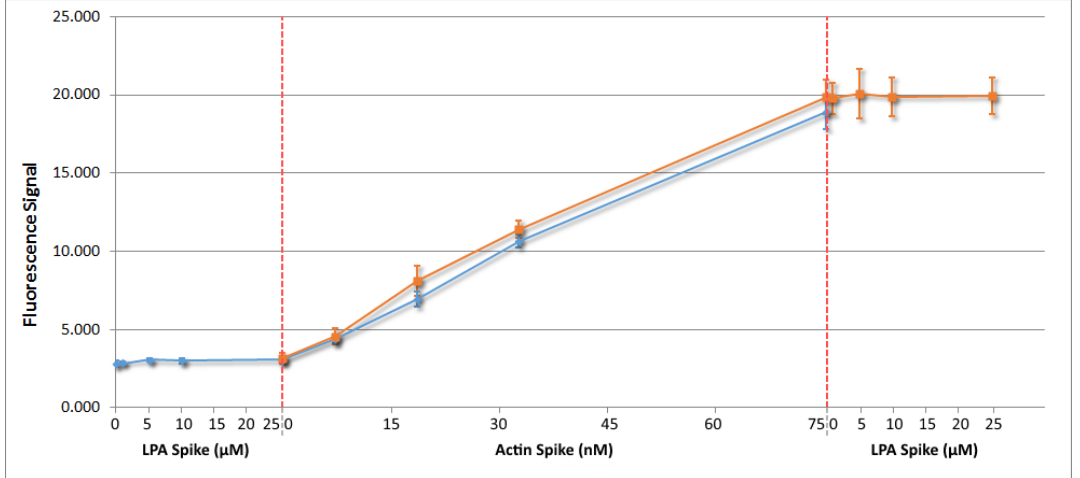
Figure 4. A non-denaturing gel where each lane contains a 1:1 mixture of gelsolin and actin that has been incubated with a varying concentration of lysophosphatidic acid (LPA).